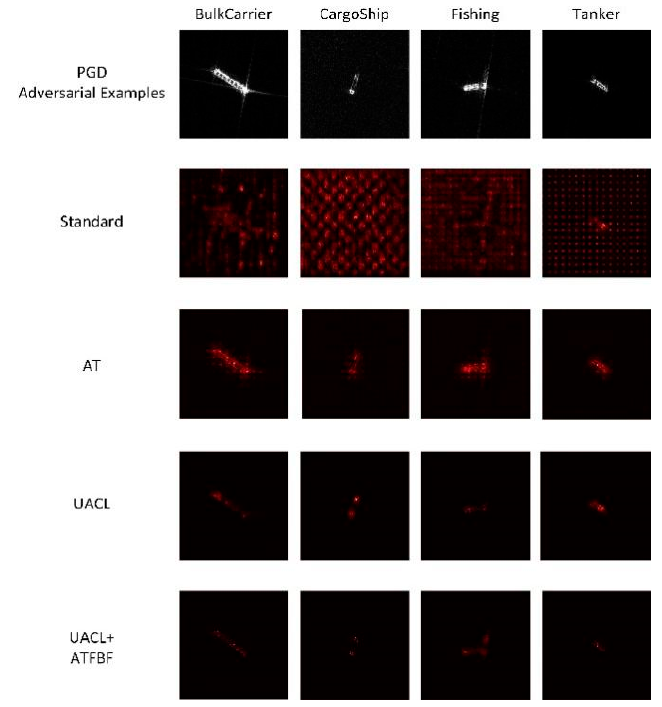
Figure 12. Guided backpropagation images of FUSAR-Ship model in the classification of adversar- ial examples.